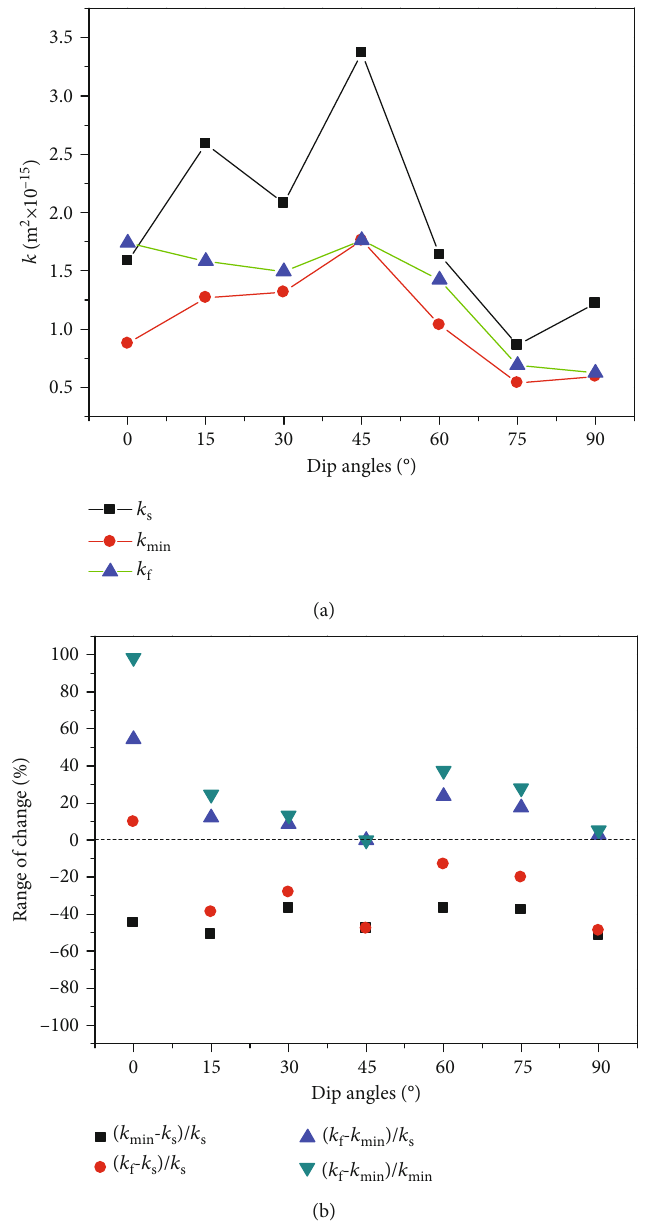
Figure 8: Relationship between permeability and change range and sample inclination under intermediate principal